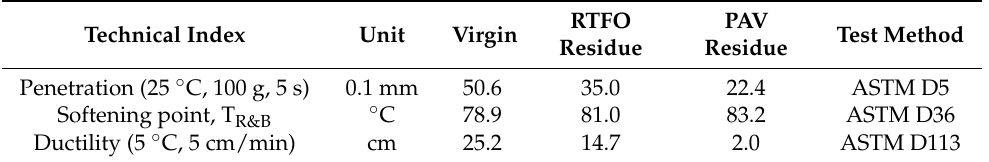
Table 1. Technical indices of SBS modified asphalt-binder (SBSMA).